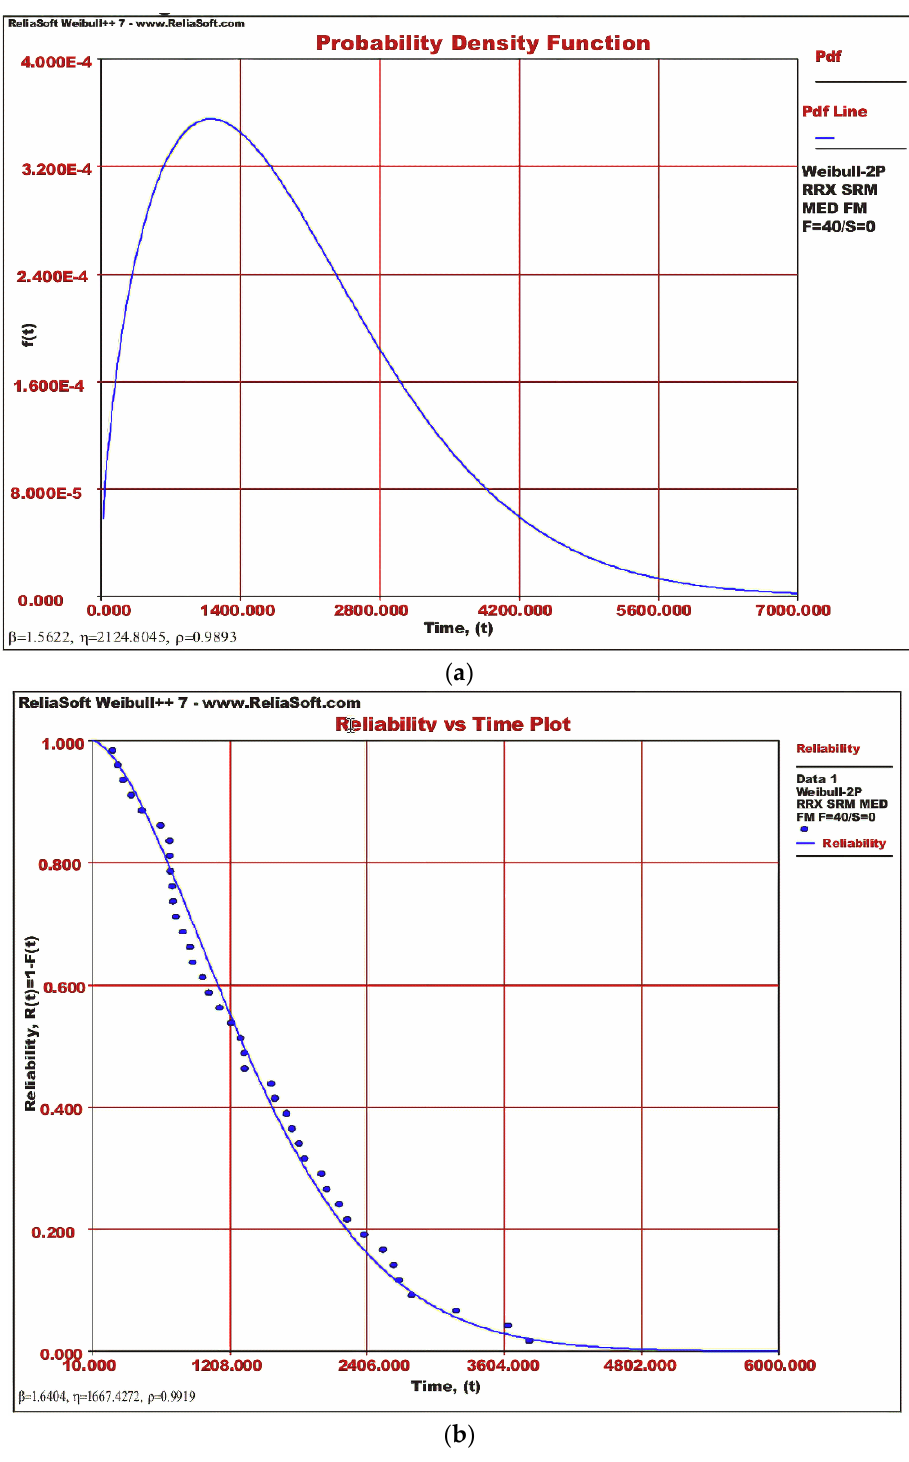
Figure 9. Reliability of diode ( a ) pdf plot for diode degradation and ( b ) reliability plot for the diode. The conditional and standard reliability results from the probability distribution function are as follows: